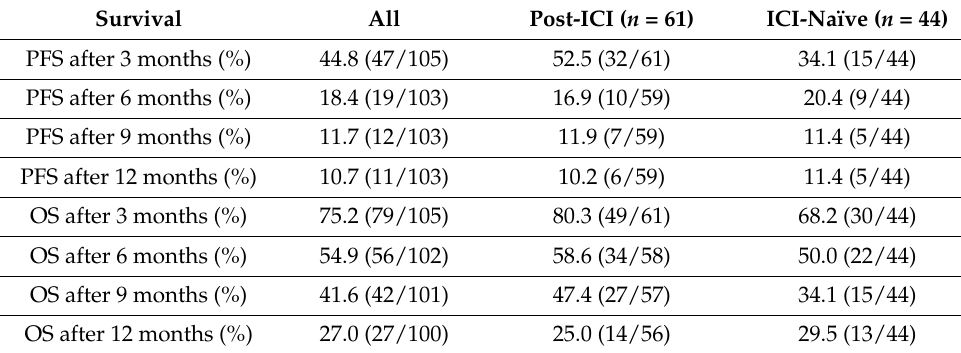
Figure 1. Kaplan–Meier curves for PFS and OS in both cohorts. Table 3. PFS and OS rates after 3, 6, 9, and 12 months.